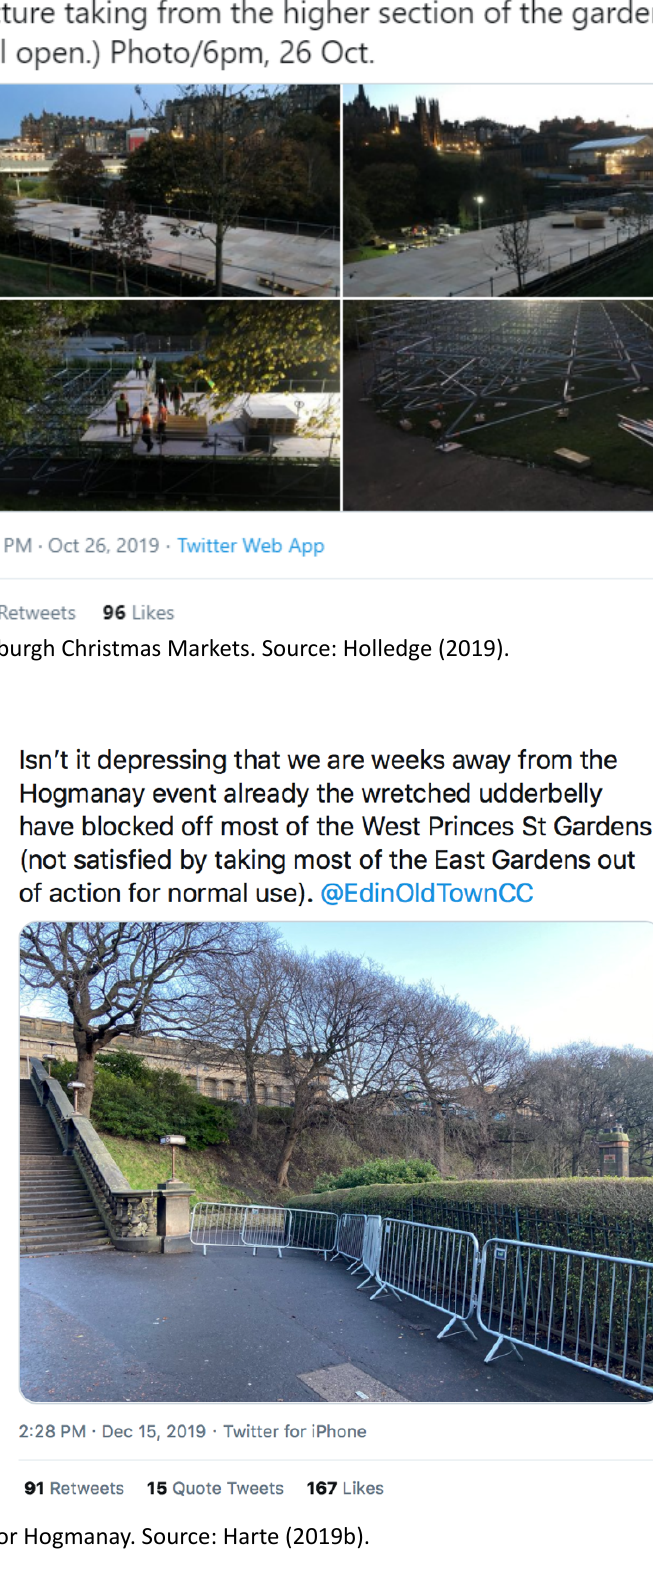
Figure 4. Closed Gardens for Hogmanay. Source: Harte